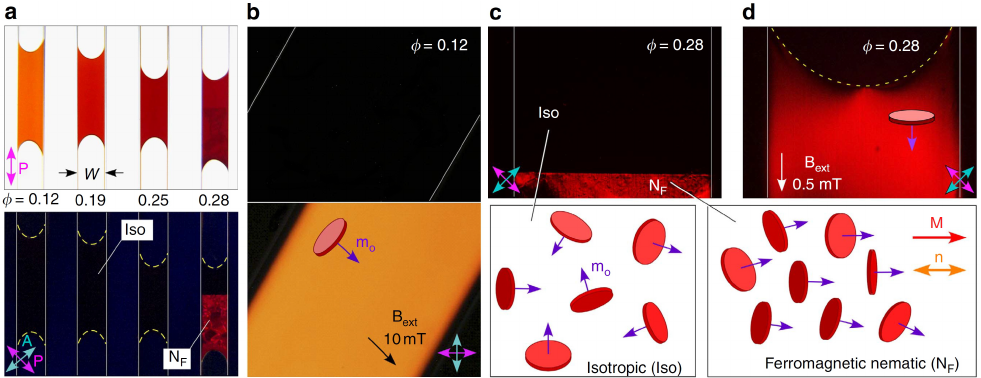
Figure 11. Nematic ferrofluid from suspension of barium ferrite nanoplatelets in n-butanol. ( a ) Nanoplatelet suspensions viewed in transmitted light with optical polarization conditions indi- cated (Polarizer: magenta, P; analyzer: cyan, A). Low-volume fraction suspensions are isotropic (Iso), appearing dark between crossed polarizers. The orange/red color is due to optical absorption by the nanoplatelets. At higher concentrations ( φ (cid:38) 0.28), a birefringent ferromagnetic nematic (NF) phase appears in the lower part of the cell. ( b ) An applied in-plane magnetic field induces birefringence in the isotropic phase, with the principal axes of the optical dielectric tensor along and normal to external magnetic field and the induced macroscopic magnetization density parallel to external magnetic field. ( c ) The NF phase is separated gravitationally from the isotropic region by a sharp, horizontal interface. Equilibrium Iso and NF structures deduced from birefringence and dichroism measurements are illustrated. ( d ) The Iso phase is magnetized, and the Iso–NF interface becomes continuous, under applied magnetic field. Samples are sealed in rectangular glass capillaries. The boundaries of the cells are indicated by the solid thin white lines, and the air–liquid interfaces are indicated by the dashed yellow lines. The image is reprinted and adapted with permission from the reference [20]–Copyright (2016) Springer